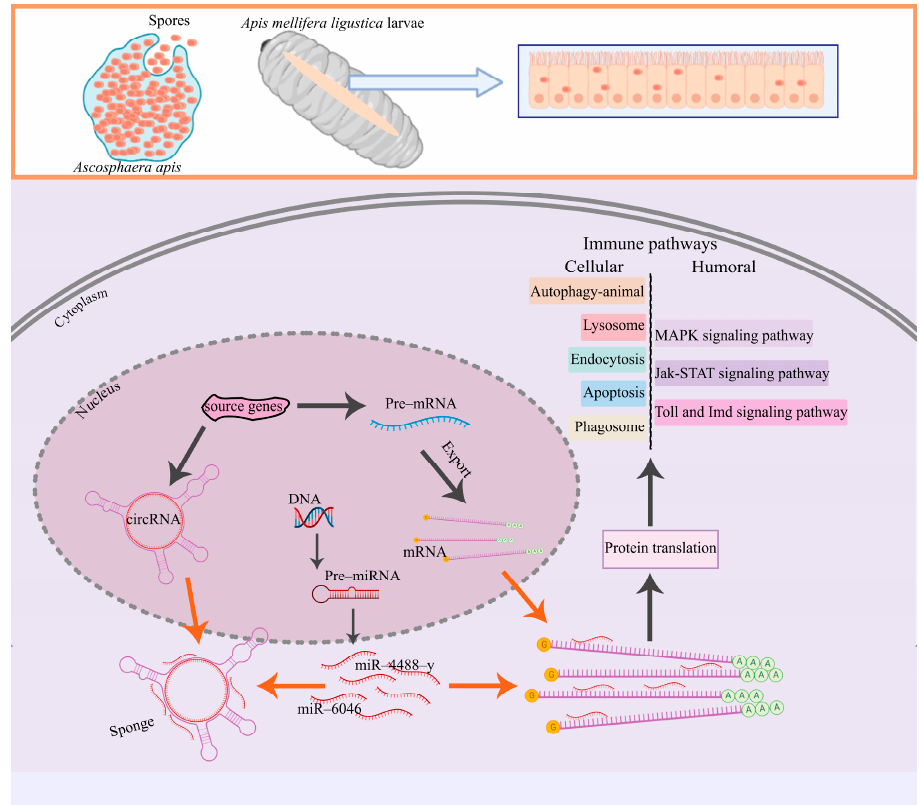
Figure 9. A hypothetical schematic diagram of circRNA-mediated immune responses of western honey bee larvae to A. apis invasion. The blue arrow indicates the enlarged view of larval epithelial cells; the orange arrows indicate the competitive binding of miRNAs between DEcircRNAs and DEmRNAs; the black arrows indicate the transcription of source genes and the translation of source gene-derived DEmRNAs as well as downstream cellular and humoral immune responses.